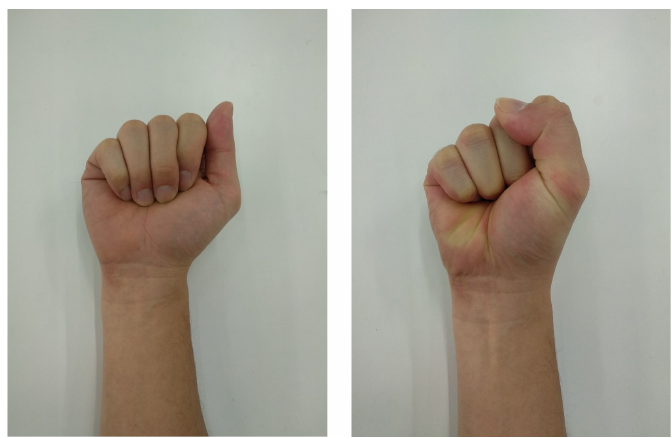
Figure 1. Rhythmic gesture by relaxing ( left ) and clenching ( right ) the fist.